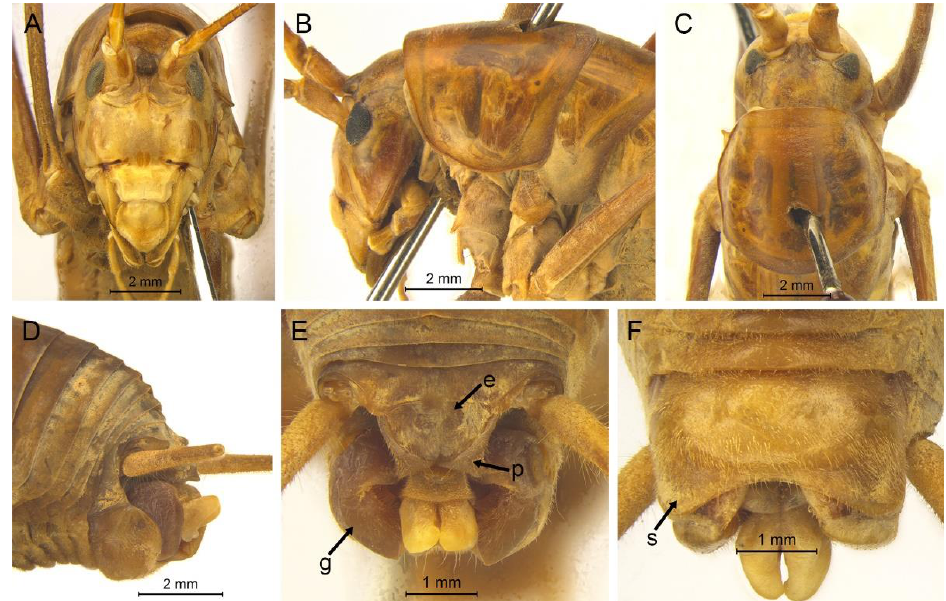
Figure 5. Gymnaetoides petalus Zhu & Shi sp. nov., male: ( A – C ) head and pronotum: ( A ) frontal view, ( B ) lateral view, ( C ) dorsal view; ( D – F ) apex of abdomen: ( D ) lateral view, ( E ) dorsal view, ( F ) ven- tral view. Abbreviations: e = epiproct; p = paraproct; g = genitalia; s = subgenital plate.